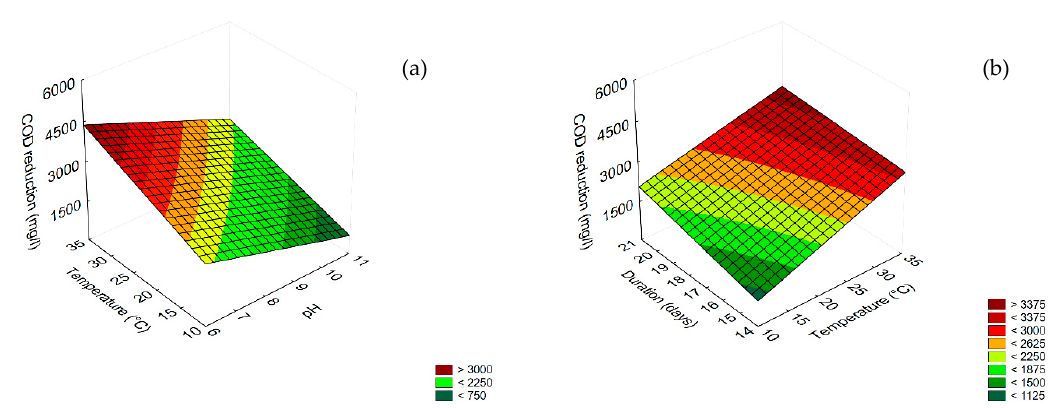
Figure 4. Surface response plots for the interaction temperature/pH ( a ) and temperature/duration ( b ) duration/pH (C) on COD reduction by T. harzianum .